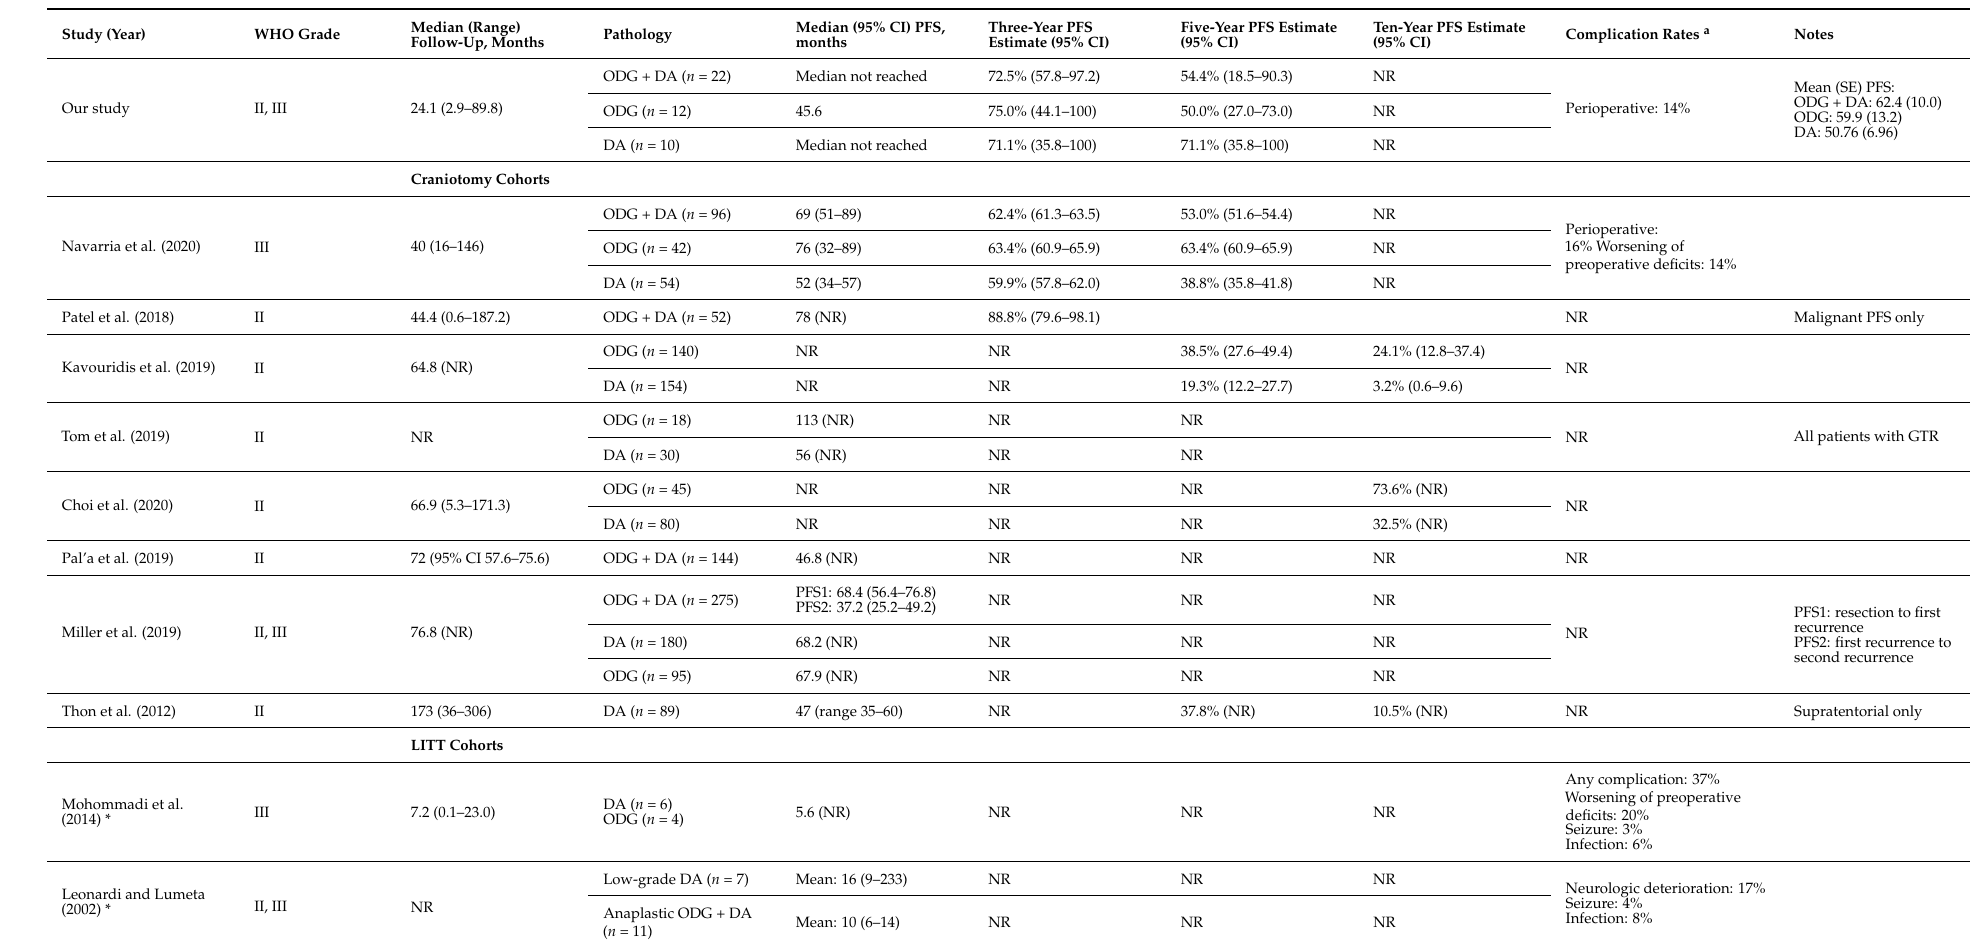
Table 5. Studies analyzing PFS in IDH1/2 mutant